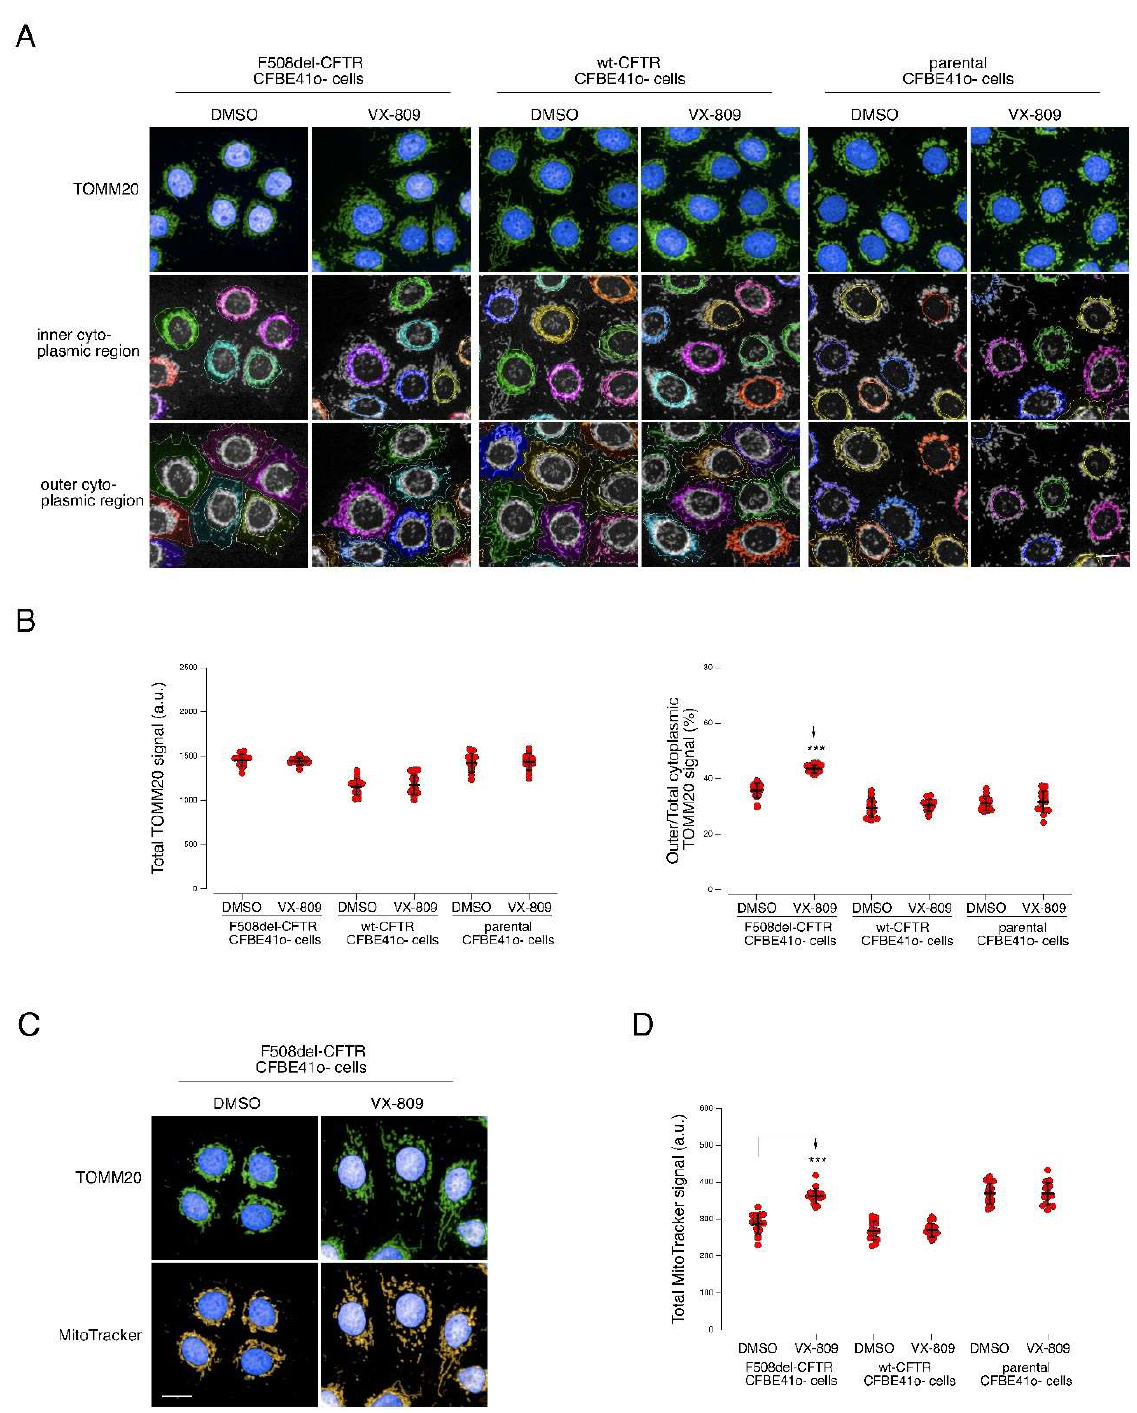
that this effect is likely specifically related to CFTR rescue by VX-809.